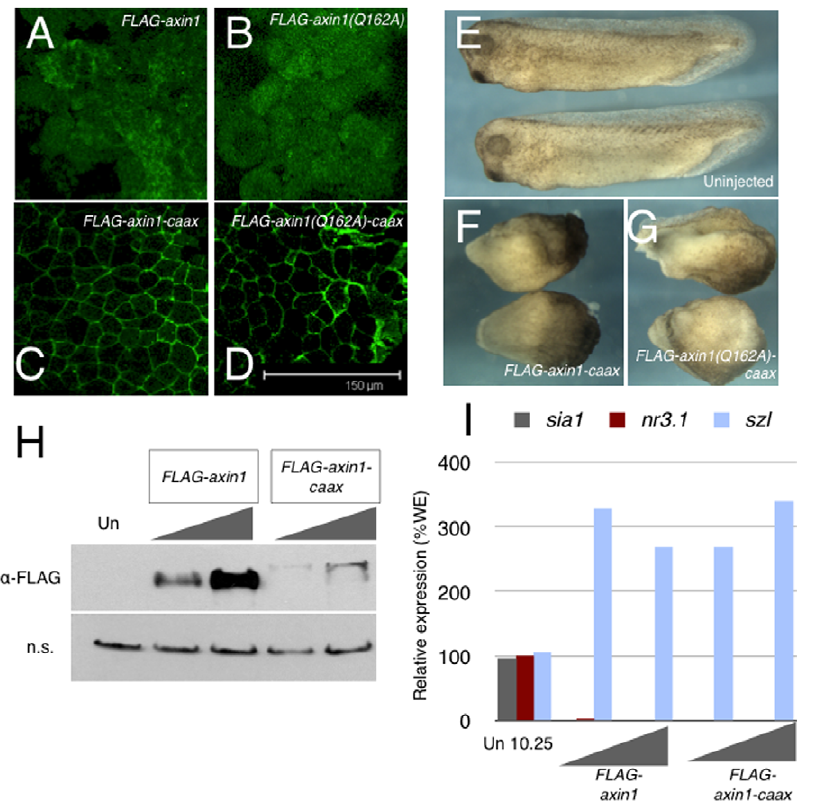
Figure 8. CAAX-tagged Axin1 is sufficient to inhibit axis formation and to promote Axin1 protein turnover. ( A–D ) Localization of CAAX-tagged and untagged Axin1 proteins in Xenopus animal caps. ( E–G ) Uninjected control embryos ( E ) and embryos expressing Axin1-CAAX ( F ) and Axin1(Q162A)-CAAX ( G ) at the tailbud stage. ( H ) Immunoblots of stage 9 embryo lysates injected with FLAG-axin1 (100 pg, 300 pg) and FLAG- axin1-caax (100 pg, 300 pg). The top panel shows anti-FLAG blotting, the bottom panel shows a non-specific band (n.s.) detected by the anti-FLAG antibody to confirm equivalent loading. ( I ) Representative realtime RT-PCR of sia1 , nr3.1 and sizzled (szl) expression in control embryos (un) and in embryos injected with FLAG-axin1 (100 pg, 300 pg) or FLAG-axin1-caax (100 pg, 300